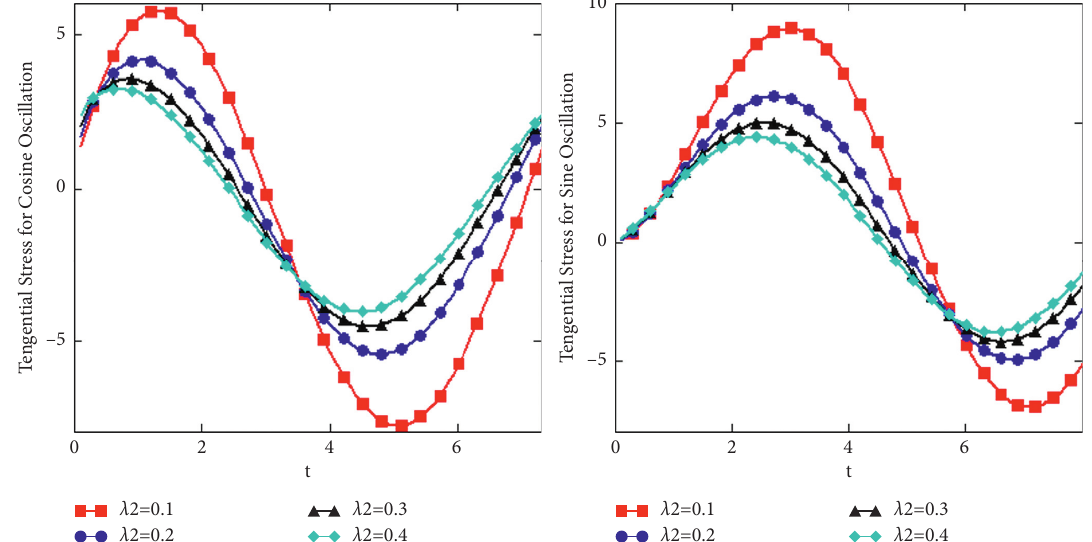
Figure 11: The variation of λ